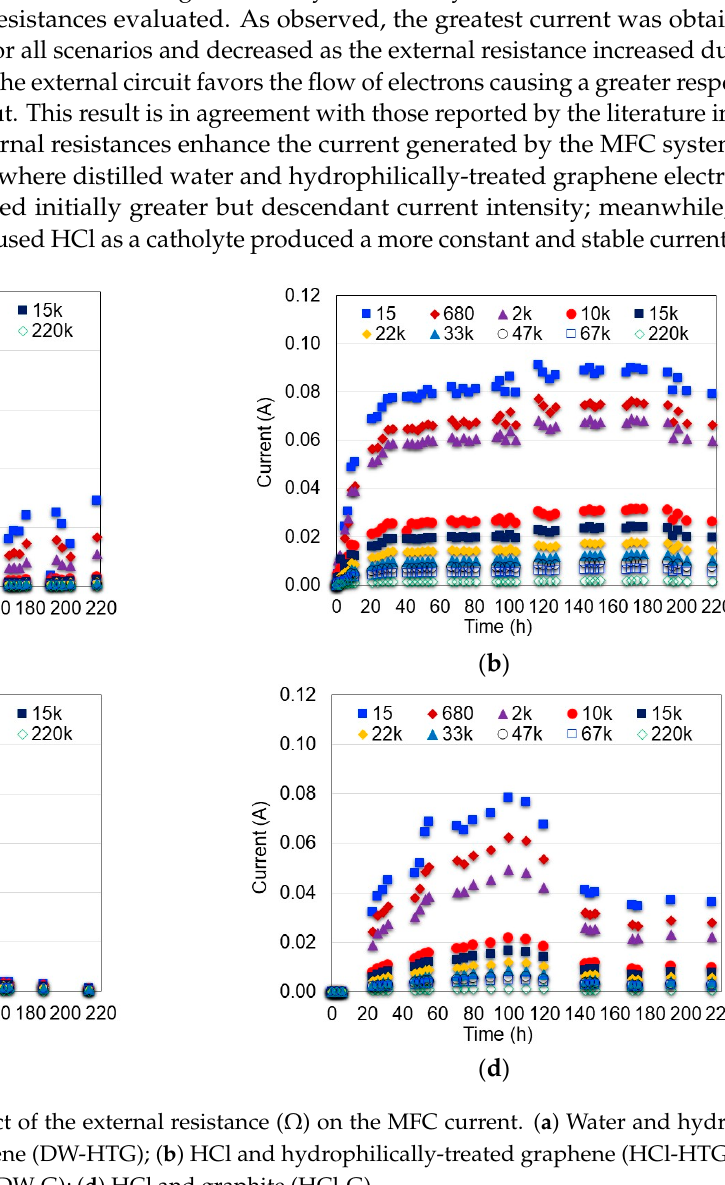
Figure 4. E ff ect of the external resistance ( Ω ) on the MFC potential. ( a ) Water and hydrophilically- treated graphene (DW-HTG); ( b ) HCl and hydrophilically-treated graphene (HCl-HTG); ( c ) Water and graphite (DW-G); ( d ) HCl and graphite (HCl-G).